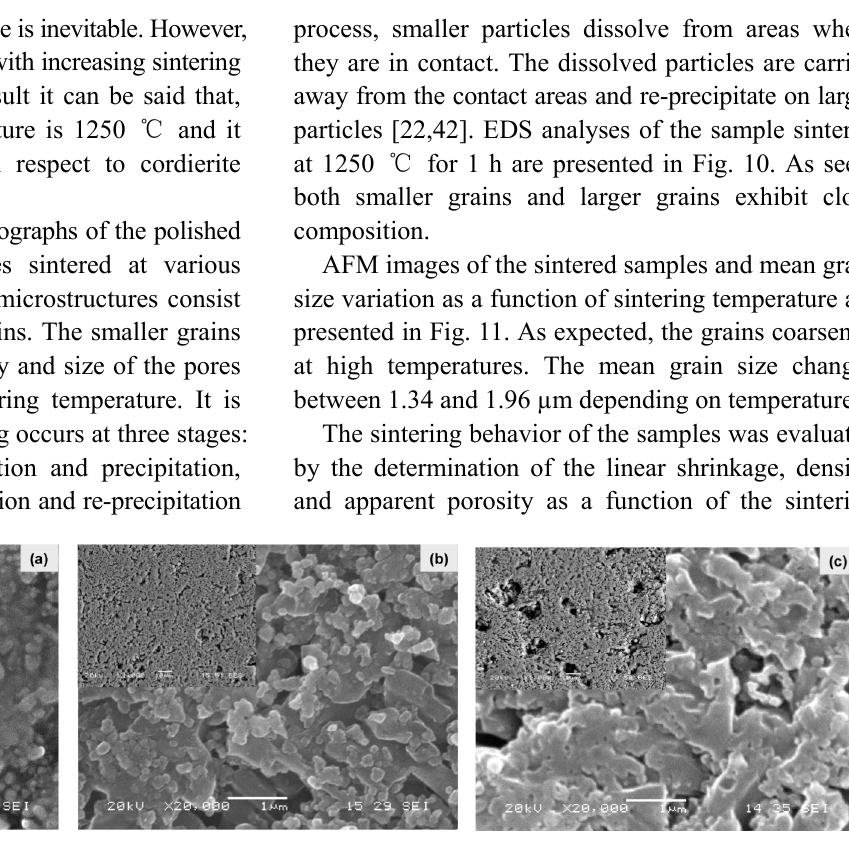
Fig. 9 SEM micrographs of the samples sintered at (a) 1150, (b) 1250, (c) 1350 ℃ for 1 h.